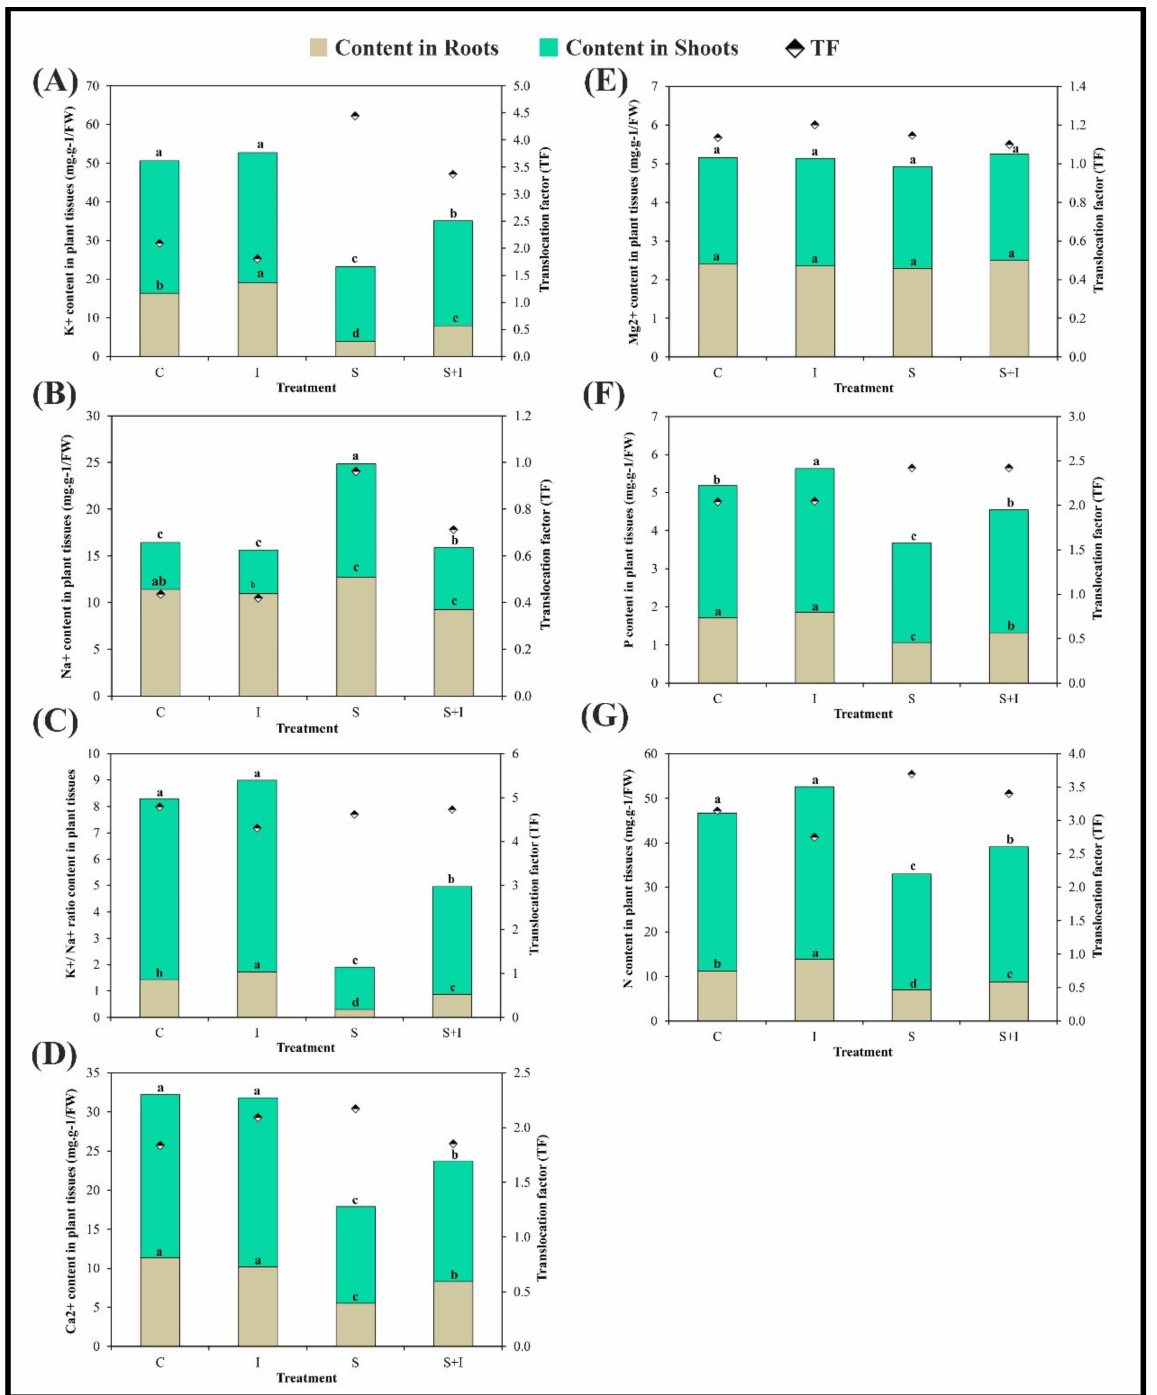
Figure 3. Effect of 0 (C), selected bioinoculum (I), 200 mM NaCl (S), and their interactions on elements content: ( A ) = potassium (K+), ( B ) = sodium (Na+), ( C ) = K+/Na+ ratio, ( D ) = calcium (Ca2+). ( E ) = magnesium (Mg2+), ( F ) = phosphorous (P), and ( G ) = nitrogen (N) and translocation factor (TF) (mineral content in shoots/mineral content in roots) in the roots and shoots of S. melongena L. plants 66 days after sowing. Values are means ± SD based on triplicate independent determinations, and different letters means a significant difference as evaluated by Duncan’s multiple comparison test ( p <